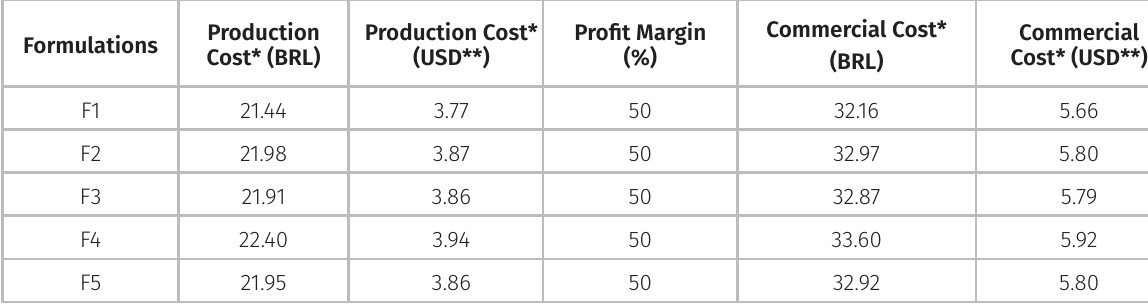
Table VI. Commercial value of the liqueur formulations.